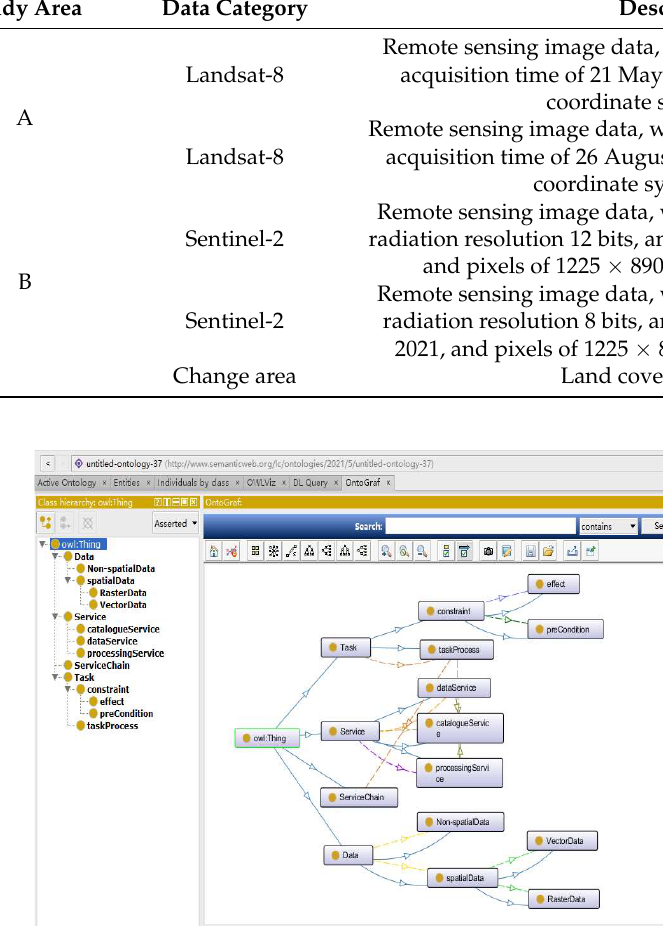
Figure 8. The schematic structure of the LCSOnt in protégé.